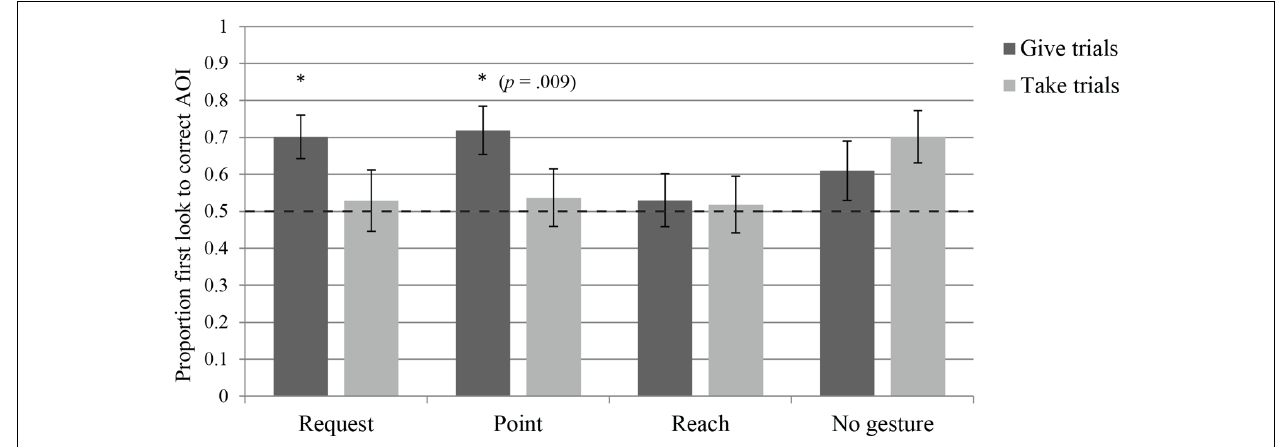
FIGURE 4 |Average proportion of first looks to the target bowlAOI during the anticipatory phase of each of the four groups, separated into give trials – where theAddressee gave the object to the Gesturer – and